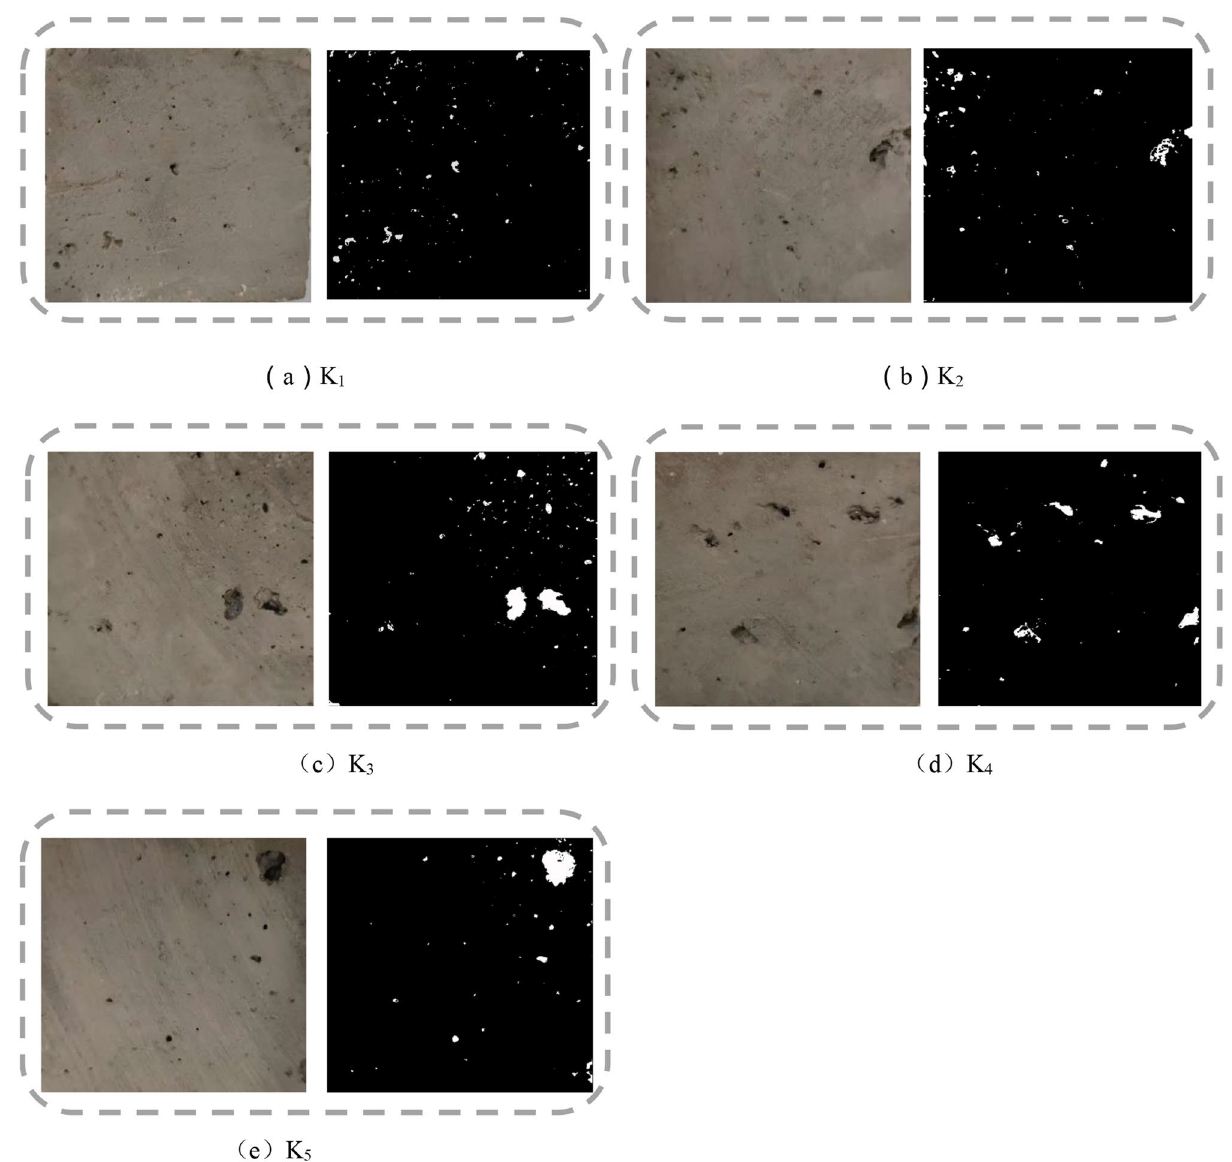
Figure 15. Hole inside the sample.